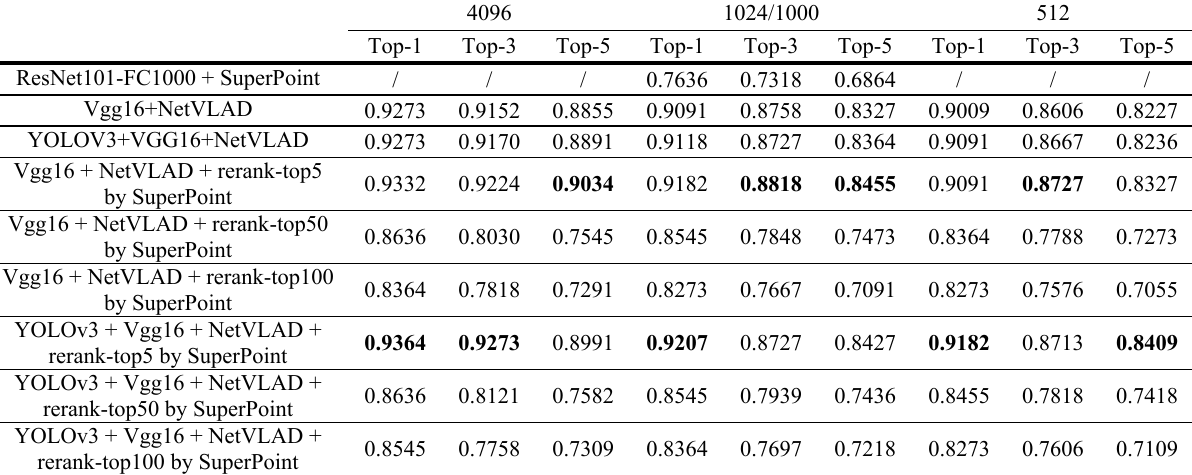
Table 4. Precision statistics of hierarchical retrieval solutions on Mixed Buildings dataset, and The precision of nine tests using global feature descriptors in dimension of 4096, 104/1000 and 512 were provided, and best results are highlighted in bold